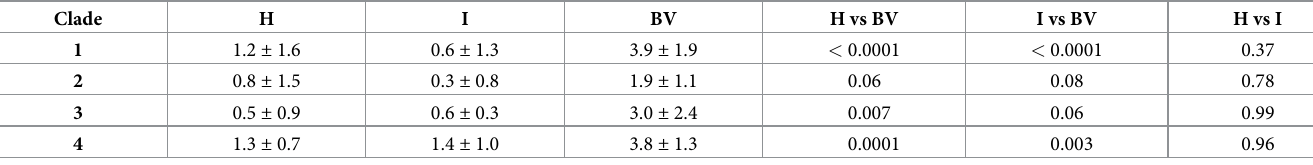
Table 1. GV bacterial loads stratified by the vaginal status (Nugent